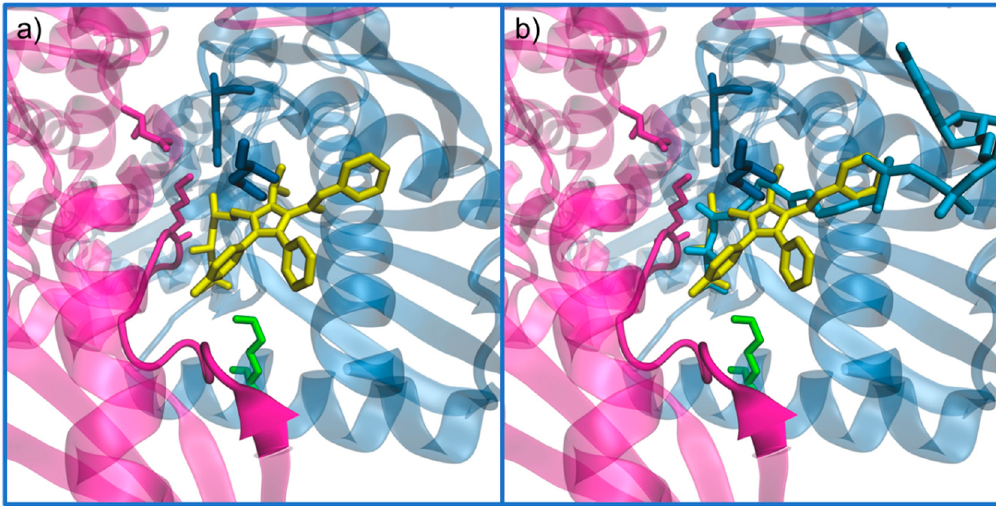
Figure 13. Demonstration of the active site residues when a statin (atorvastatin) is bounded (PDB code 1HWK): ( a ) only atorvastatin is presented in yellow; and ( b ) HMG-CoA is also bound to more easily compare the inhibitor with the natural substrate (PDB entry 1HWK and 1DQ9). These structures follow the representation and color code of the dimer in Figure 6, as chain A and B are colored in magenta and blue (transparent to better see details), respectively.